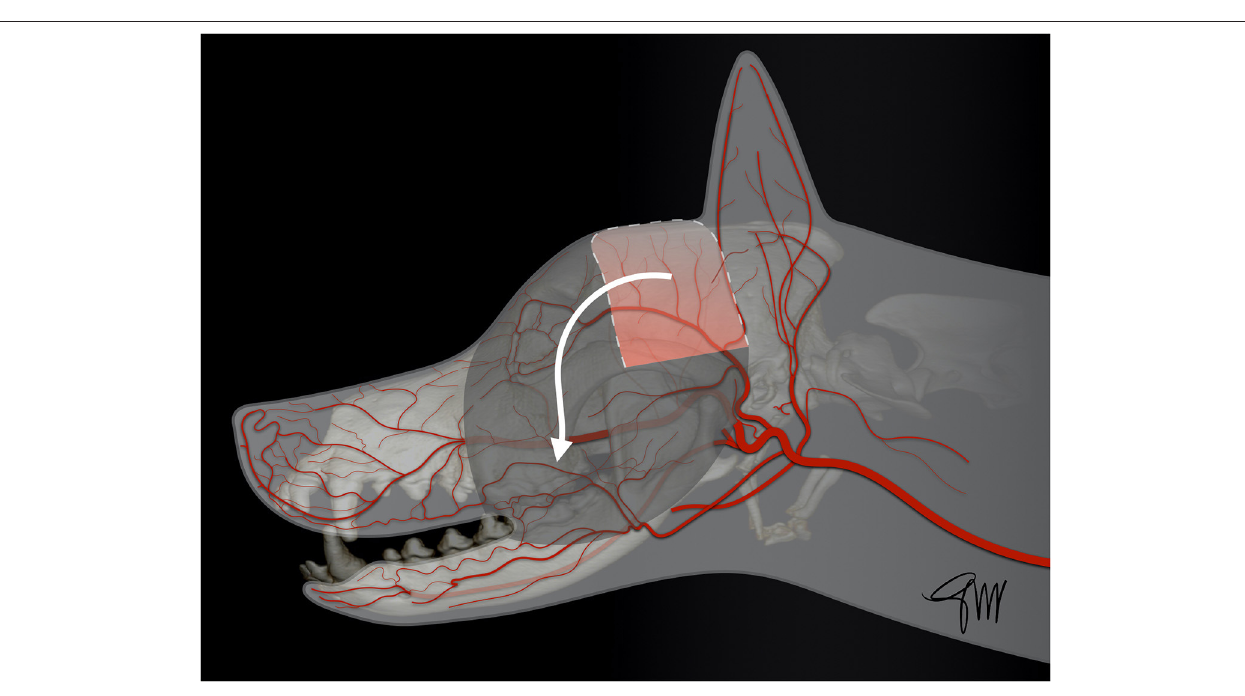
minor revision surgery in two of them (112). Frasson et al. (108) reported the outcome of the flap in 6 dogs. Three of the 6 flaps showed minimal suture dehiscence but all flaps healed without necrosis of any portion of the flaps and did not require revision surgery (108). In both series, the caudal limit of the flap was